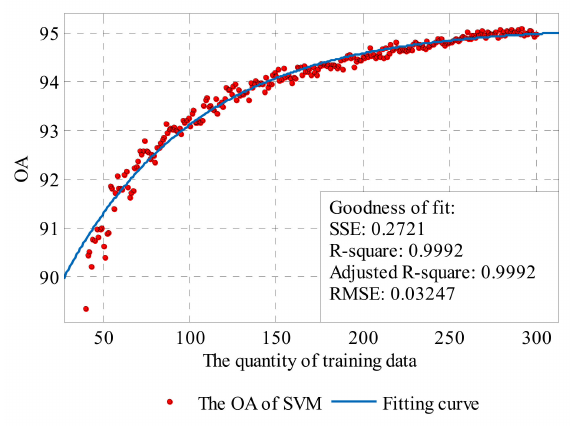
Figure 18. The exponential curve fit to the performance results of the